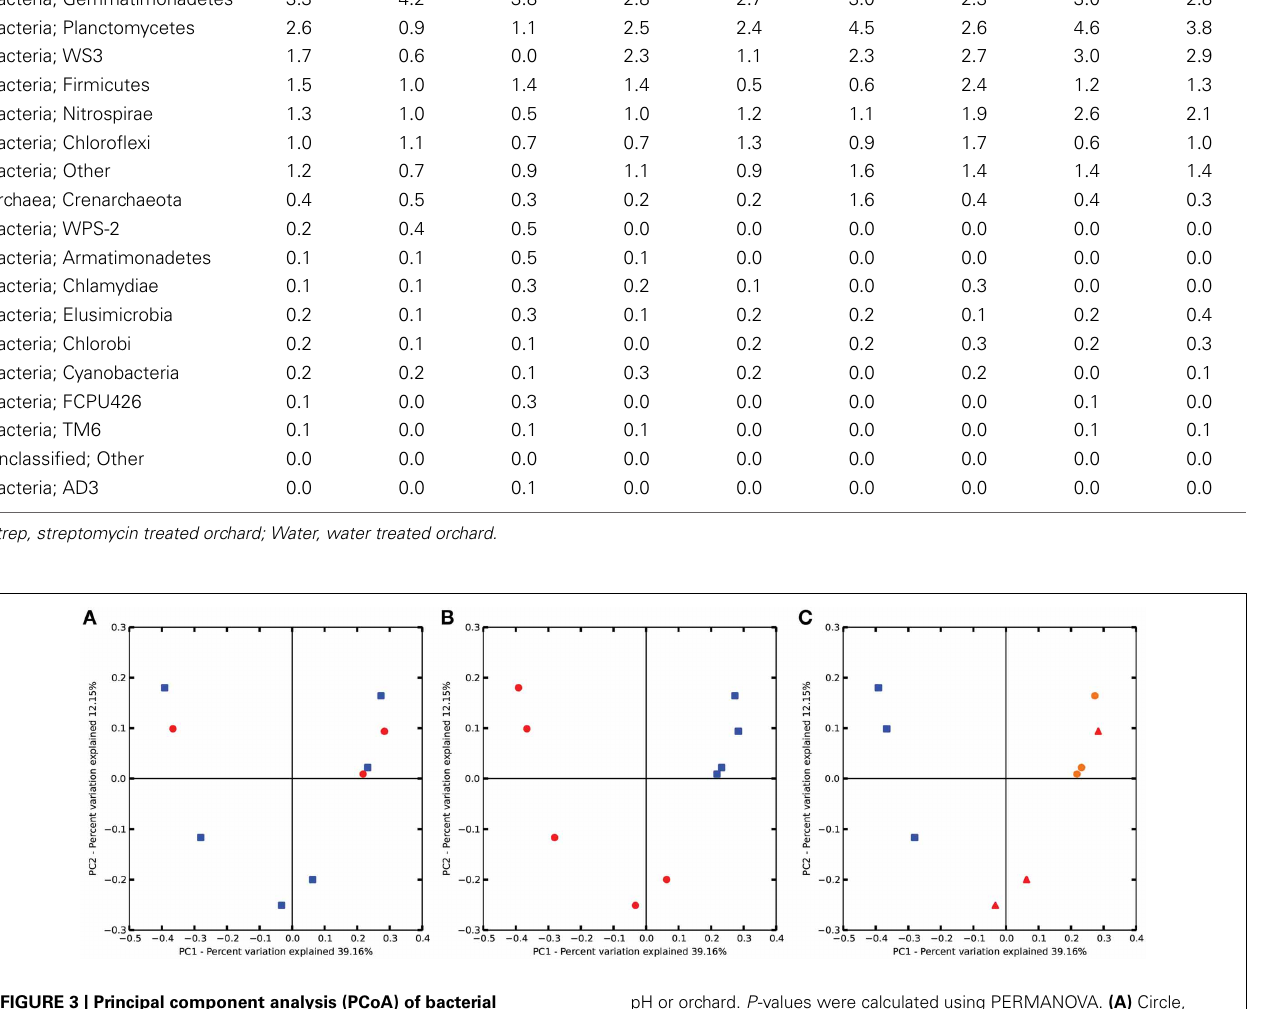
FIGURE 3 | Principal component analysis (PCoA) of bacterial communities as affected by (A) Treatment of streptomycin or water, (B) soil pH, and (C) soil site orchard. Plots are based on Bray-Curtis dissimilarities comparing bacterial communities according to treatment, soil